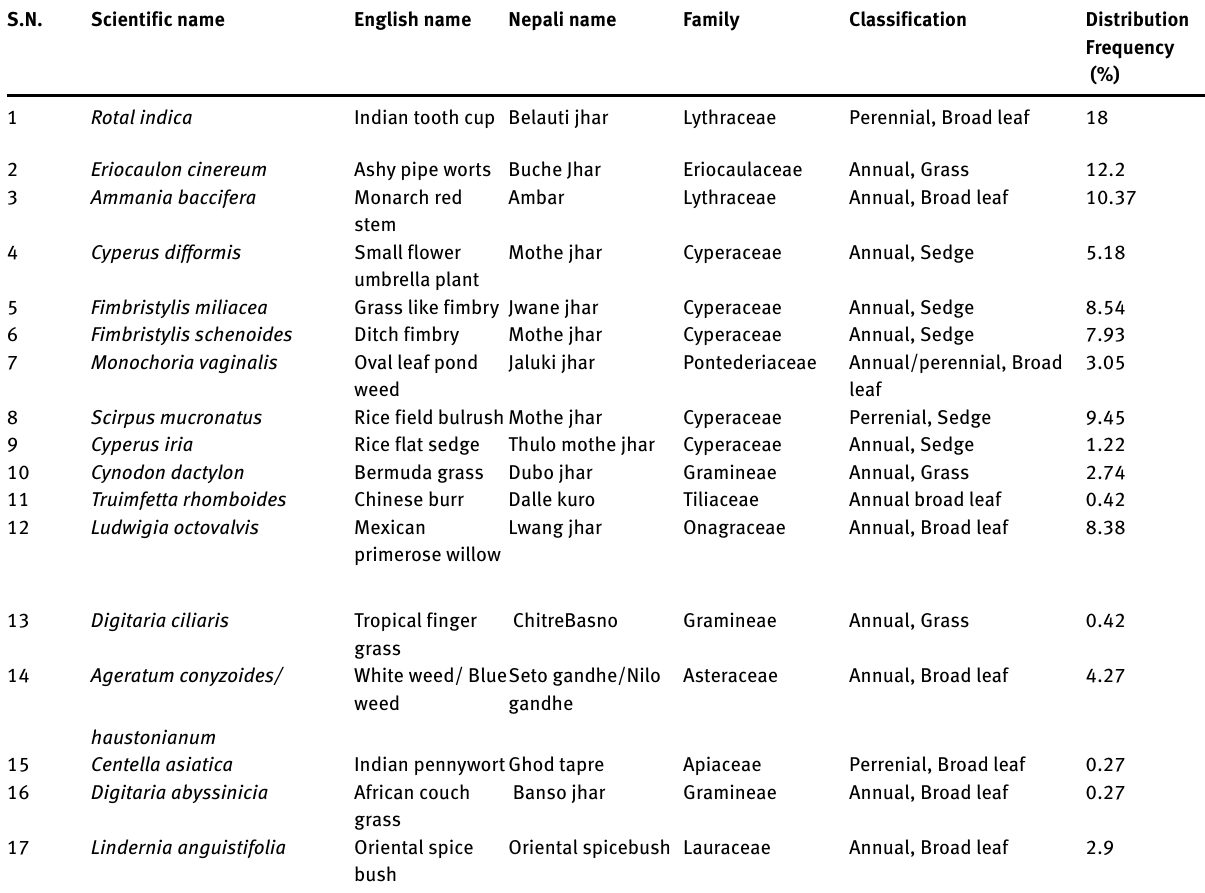
Table 4 . Frequency distribution of different weed species at experimental rice field of Sundarbazar, Lamjung in 2016 S.N.